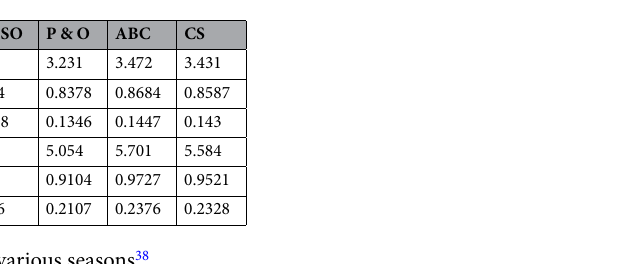
Table 4. Comparative analysis in various seasons 38 .